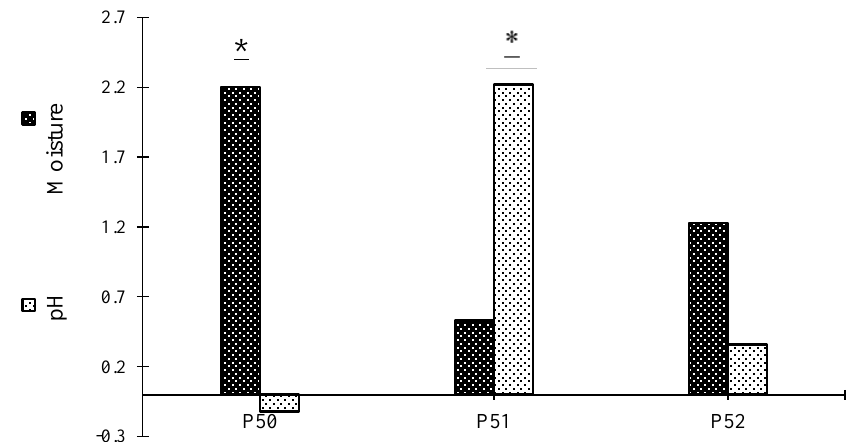
Figure 1. Moisture (%) and pH. Difference of t f - t 0 . * Statistically significant difference.